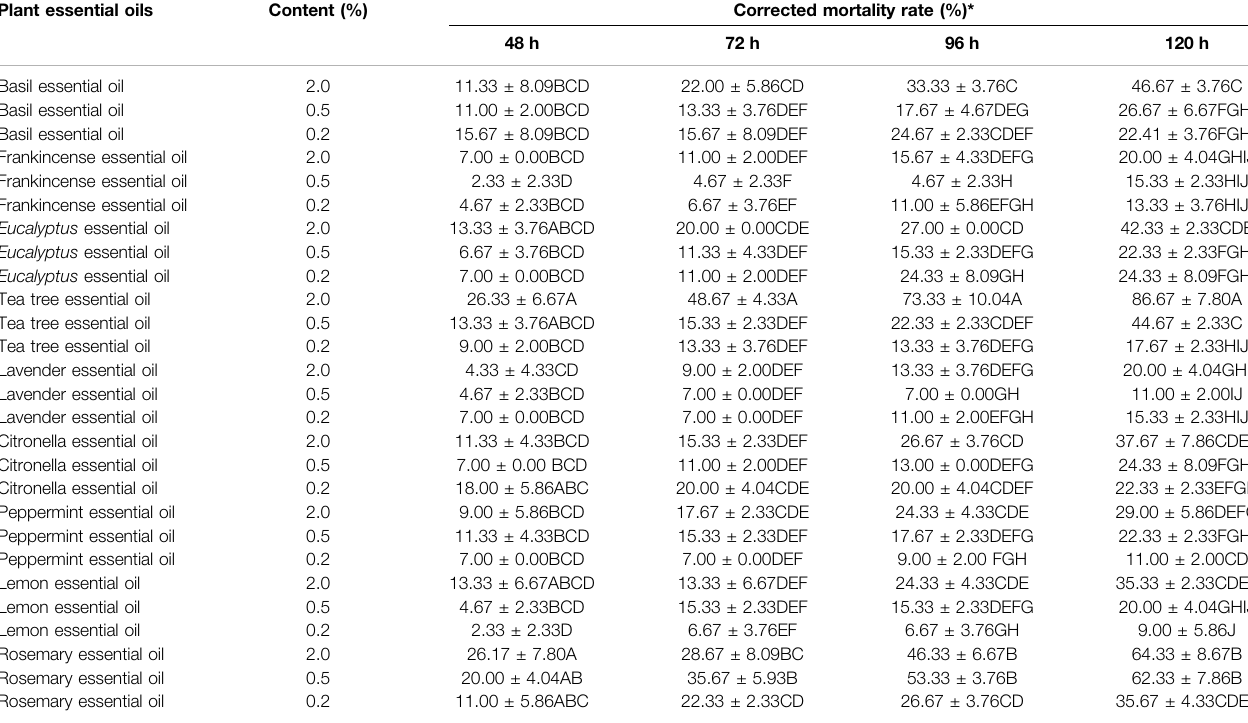
TABLE 2 | The fumigation activity of plant essential oils against armyworms larvae. Plant essential